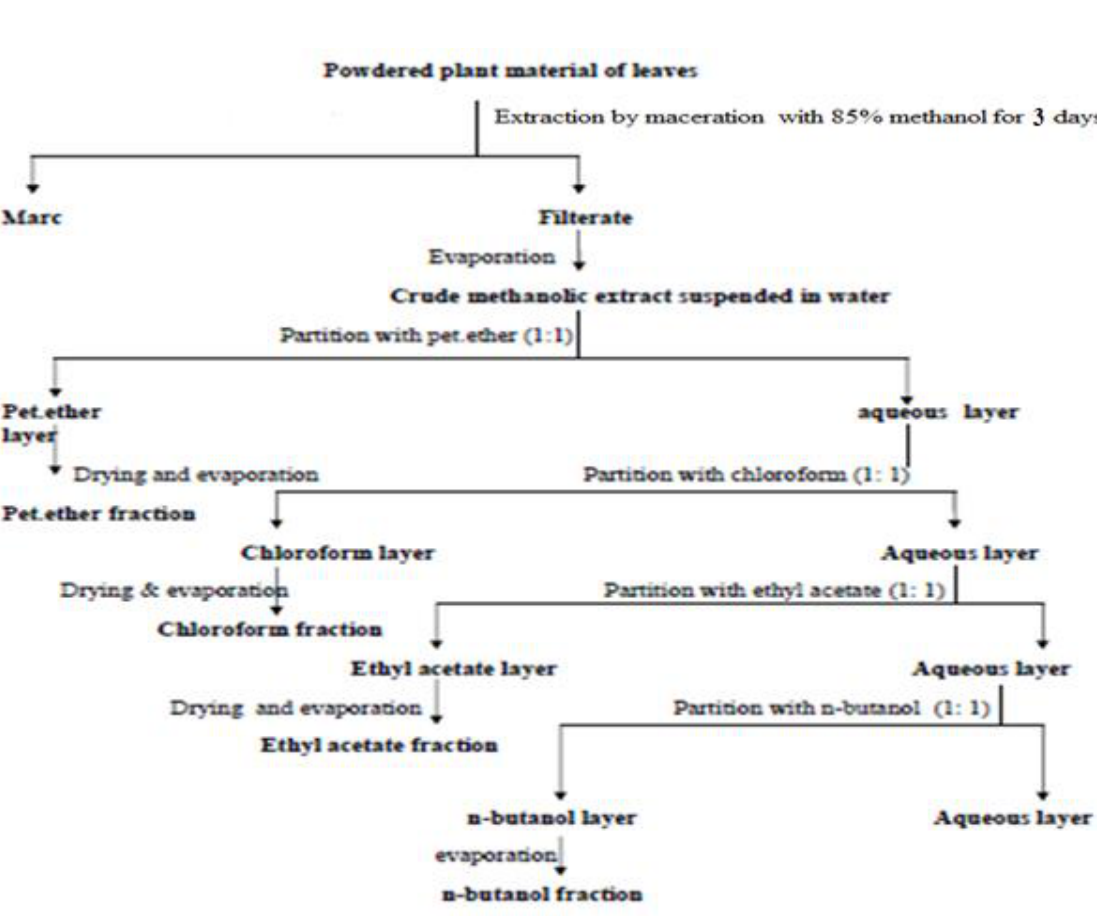
Figure 2. Schematic diagram for fractionations aerial part crude extracts of Borago officinalis (14